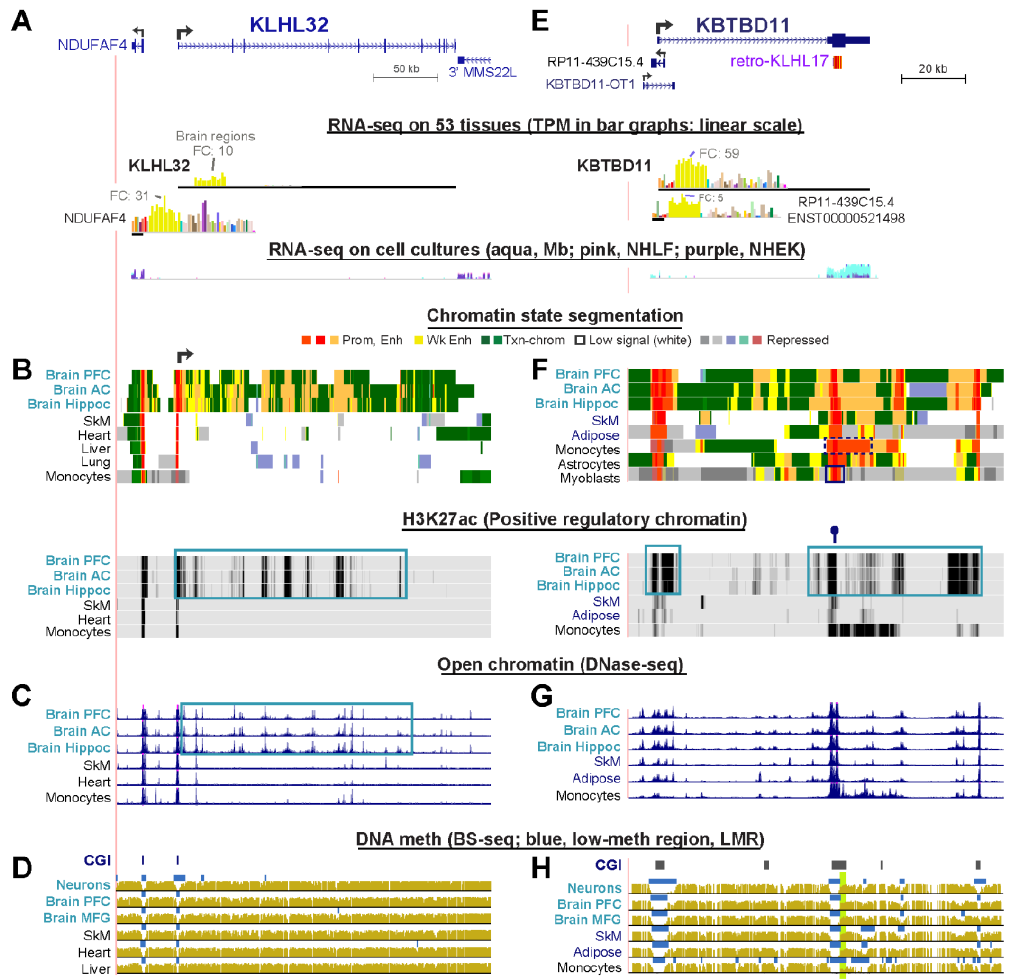
Figure 4. Multiple segments of enhancer chromatin without brain-specific DNA hypomethylation are associated with highly preferential expression in brain of KLHL32 and KBTBD11 . ( A – D ) KLHL32 (chr6:97,324,594-97,615,081) and ( B – H ) KBTBD11 (chr8:1,917,290-1,976,132). Tracks are as in Figure 1. The GTEx RNA-seq bar graphs are in linear scale but the scale for KBTBD11 is different from that of its 5′ overlapping antisense transcript RP11-439C15.4, as indicated by the TPM values for frontal cortex. The green highlighting in the DNA methylation tracks for KBTBD11 refers to a region with leukemia-subtype-related DNA hypomethylation as previously reported [52] and explained in Section 3. Boxed regions are tissue-specific epigenetic marks described in the text; PFC, prefrontal cortex; FC, frontal cortex; AC, anterior cortex; MFG, midfrontal gyrus; Hippoc, hippocampus.